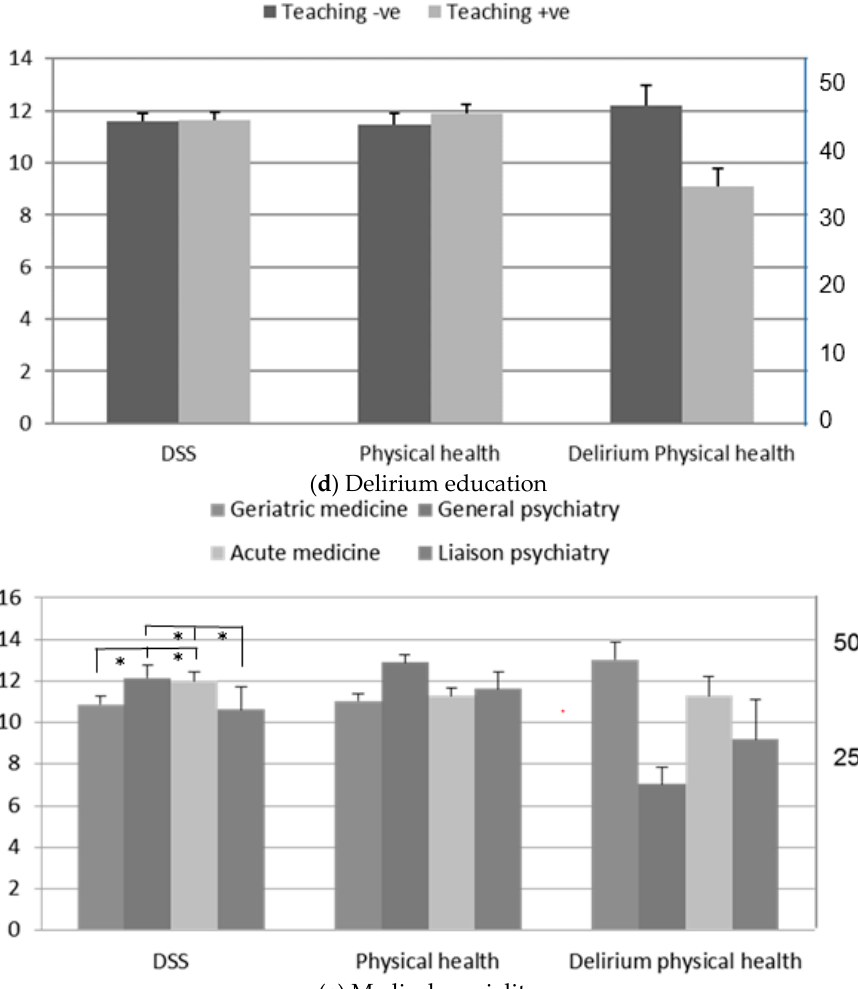
Figure 1. Analysis of delirium stigma, physical health, and delirium physical health measurements in respect to delirium in respect to ( a ) gender; ( b ) professional role; ( c ) delirium experience; ( d ) education; and ( e ) medical speciality. Physical health was determined according to EuroQol five dimensions questionnaire (EQ-5D-5L), and the delirium physical health was scored on the EQ-VAS. The scale on the left relates to the delirium stigma scale (DSS) and EQ-5D-5L measures (scores), whereas the one on the right is related to the EQ-VAS scores. Professionals working in geriatric medicine and liaison psychiatry had significantly lower DSS scores compared to professionals working in acute medicine and general psychiatry ( e ). * p <